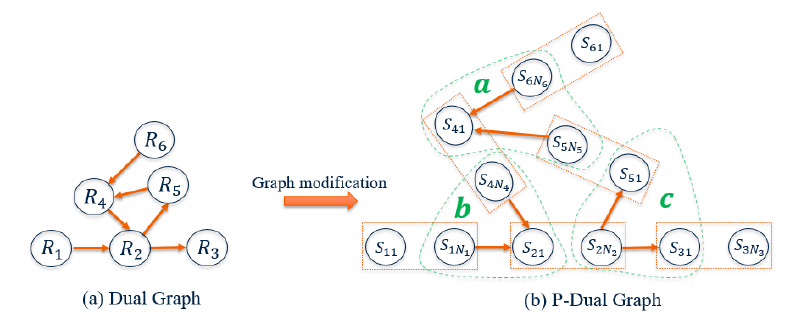
Figure 4. ( a ) Dual graph representation for the road network in Figure 1 with the nodes and arrows representing, respectively, the agents and directed edges. ( b ) P-dual graph representation for the road network in Figure 1, where two sensor nodes represent one road segment and the edge within the two sensor nodes are ignored. In this example, there exist 3 subgraphs which are denoted as a , b , and c